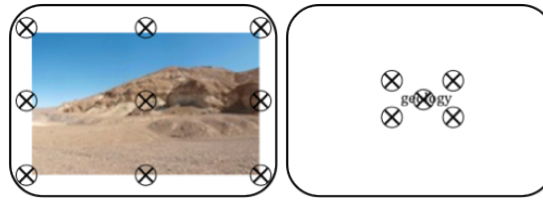
Figure 3. Sample calibration points for computer-based eye- tracking studies. Calibration points extend just beyond the stimulus borders, covering the full screen in experiments with large stimuli (nine-point array at left) and a reduced area for smaller stimuli (five-point array at right).